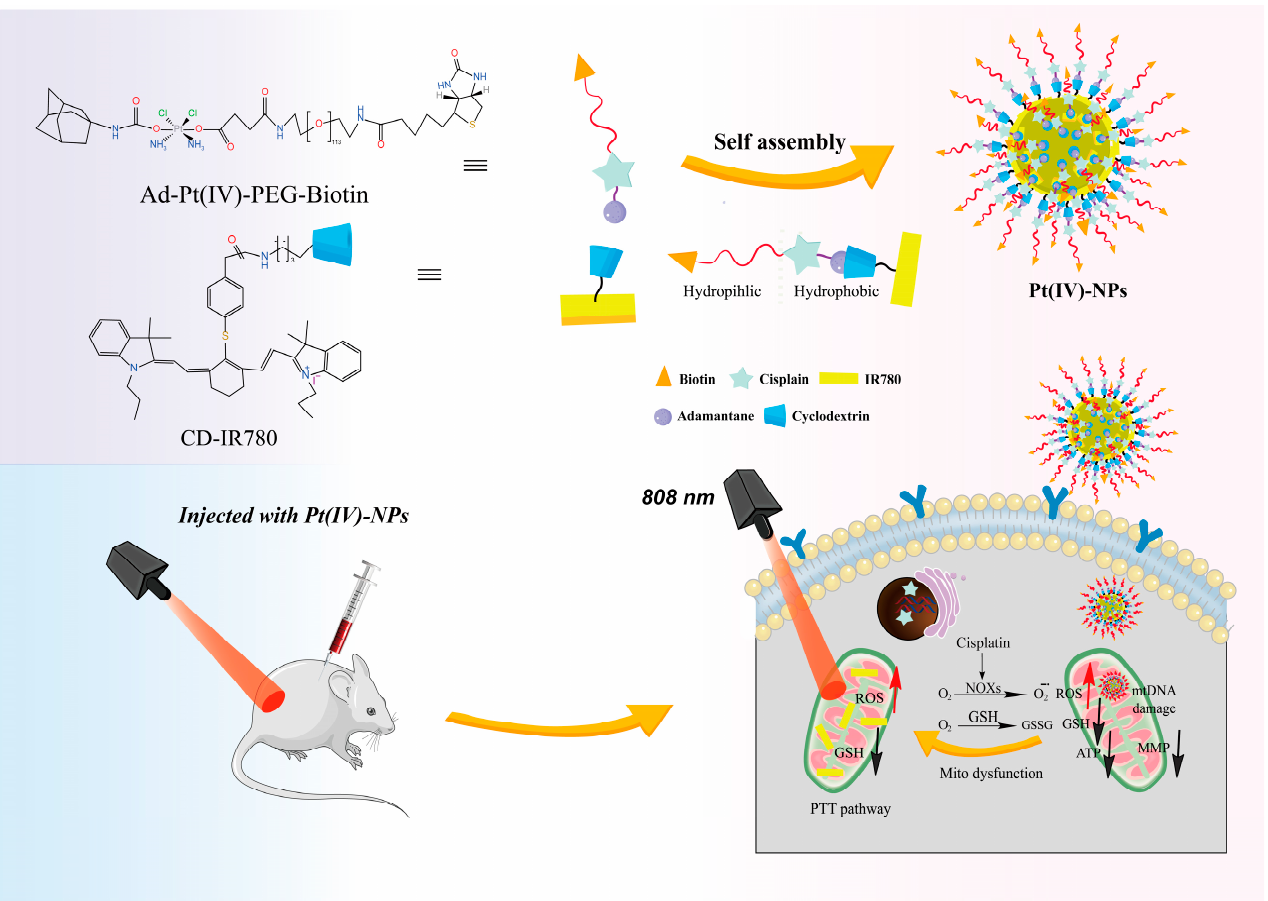
Figure 7. Mechanism of NIR-based photothermal therapy in Pt-based drugs. This structure has both hydrophilic and hydrophobic ends, which is the structural basis module for this hybrid drug’s self-assembling into nanoparticles, making the intracellular accumulation easier. Via NIR Irradiation, this basic module will be degraded into 5 parts, which then target the nucleus and mitochondrion, resulting in ROS enhancement and GSH reduction. In addition, there also exists mt DNA damage and MMP decline in the mitochondrion. Reprinted with permission from Ref. [73].